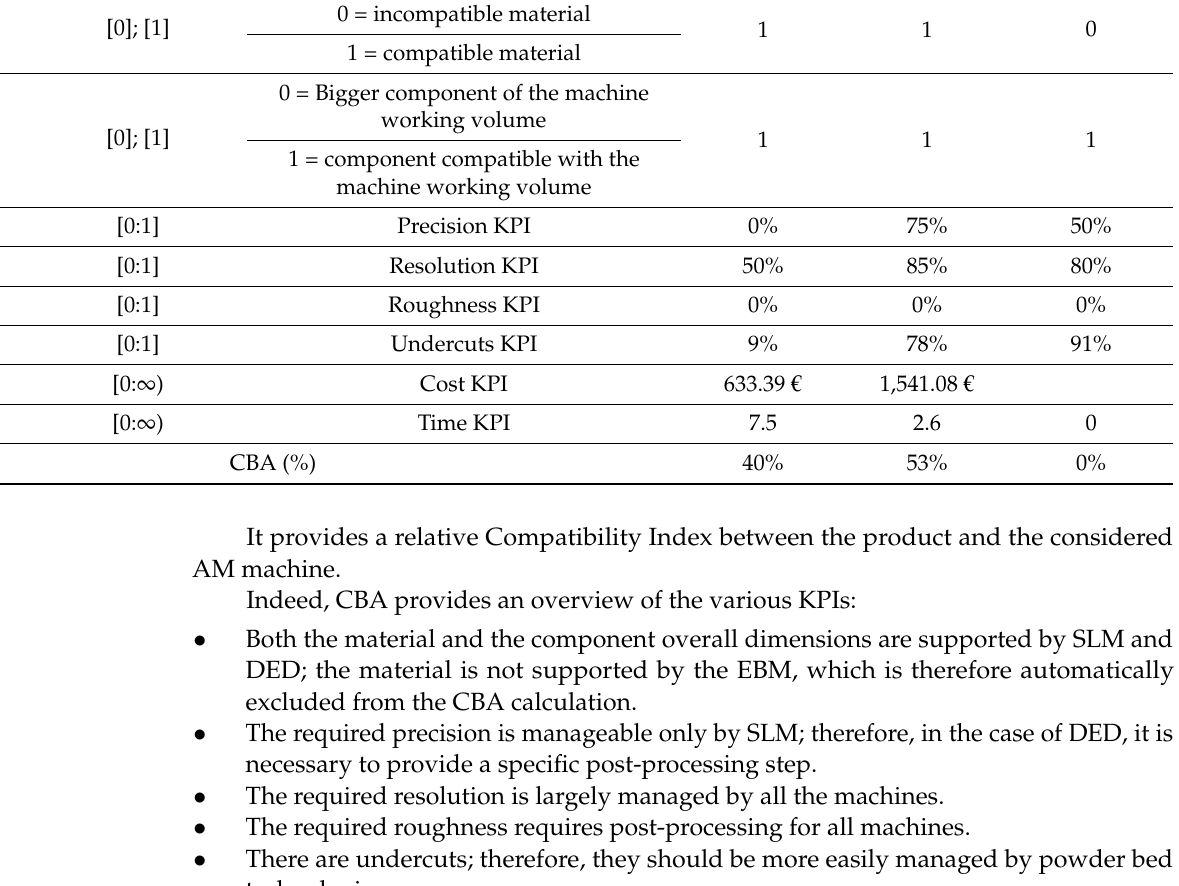
Table 10. Compatibility Index (CBA) calculation for the FDM head for traditional plastic. CBA Allowed Values Description DED SLM